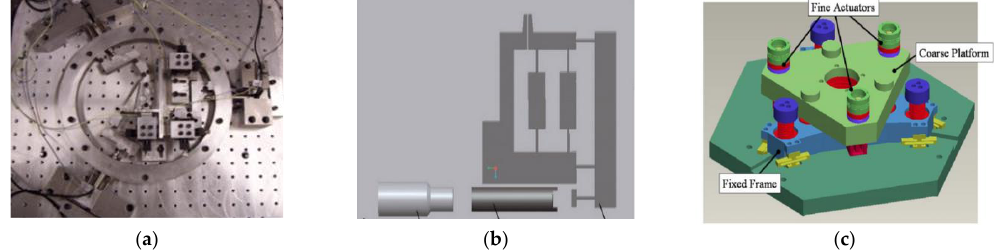
Figure 8. ( a ) Three degrees of freedom parallel micro/nano flexible mechanical system. Reprinted with permission from ref. [88] Copyright 2008 Elsevier; ( b ) The overall structure of a miniature gripper system [89]. ( c ) Solid models for the 6-degree-of-freedom mechanism employing oars and fine actuation. Reprinted with permission from ref. [92] Copyright 2010 Elsevier.